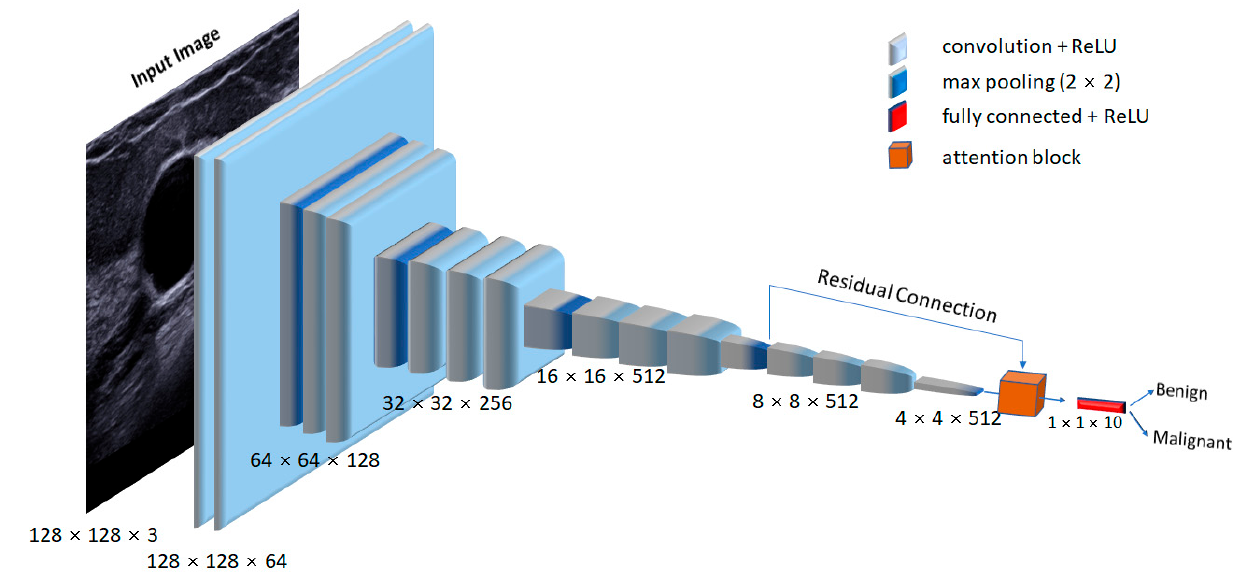
Figure 4. Proposed attention-VGG16 network. The extracted features from convolutional layer 13 were input to the attention block through a residual connection. The other input to the attention block was the feature maps from the 18th convolutional layer.